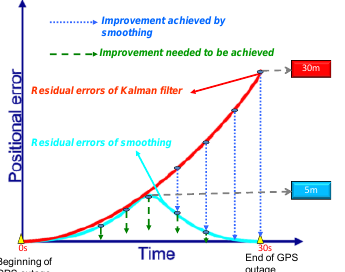
Figure 1: The KF’s positional error behaviour during GNSS outage